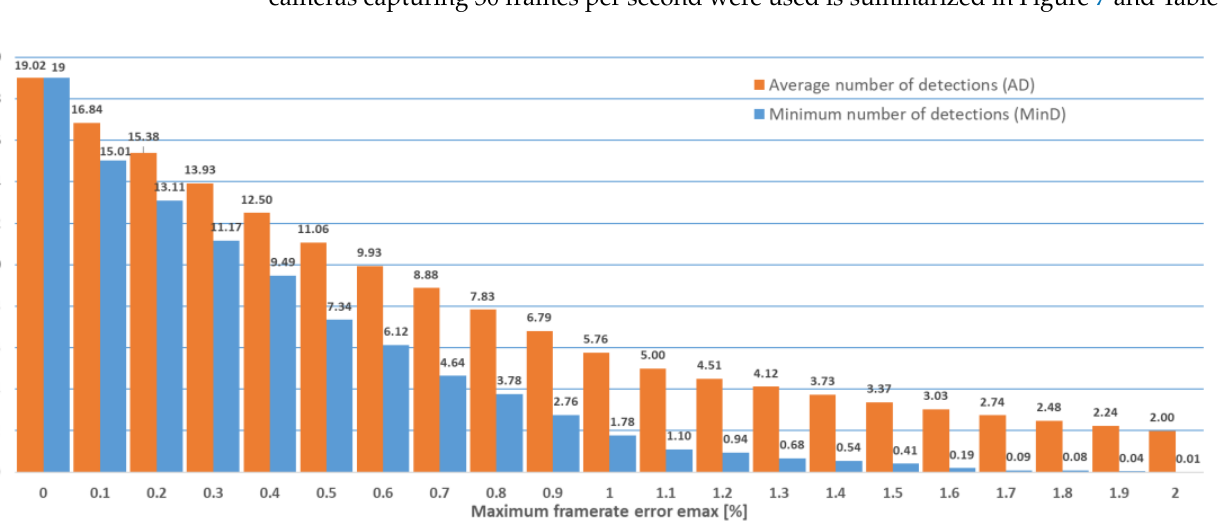
25.81 Figure 7. Minimum number of detections (MinD) and average number of detections (AD) out of a maximum of 20 (30 frames per second case).